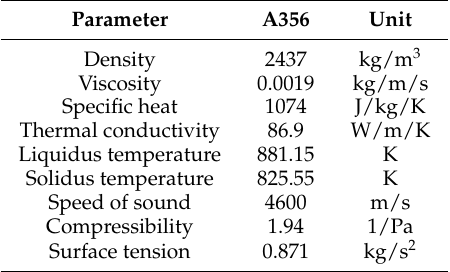
Table 1. Physical fluid parameters of A356